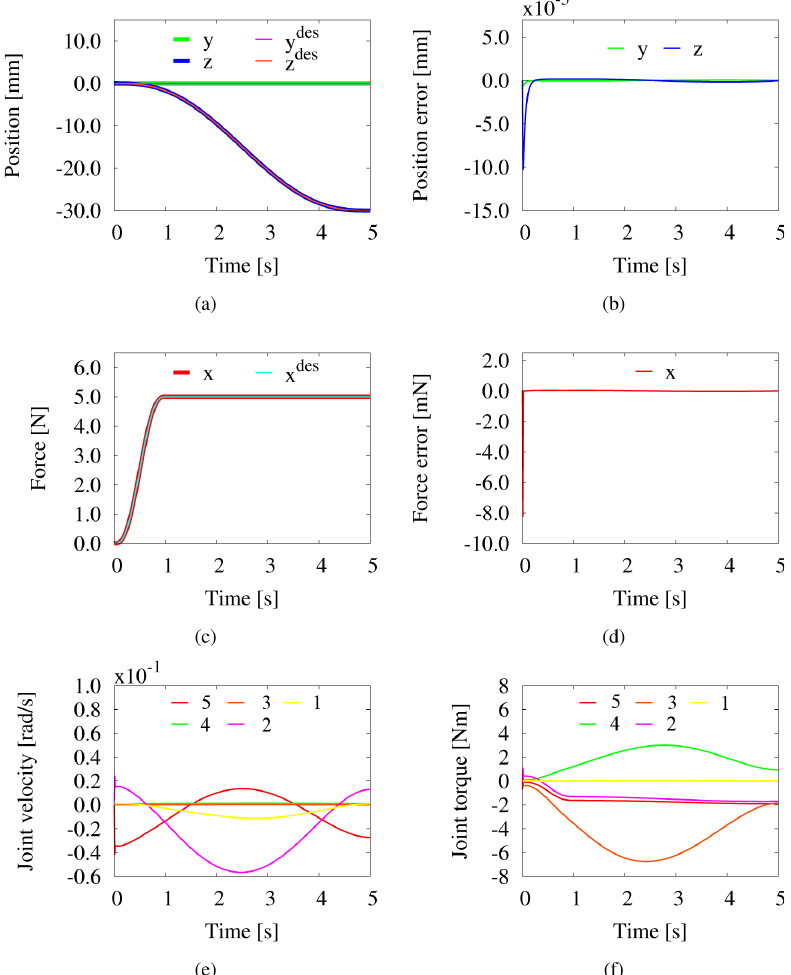
Figure 14. Simulation results under RNS-based dynamical motion / force feedback control: the desired motion trajectory in hand coordinates is a 30mm straight line downwards (along -z); the hand force (x component) is regulated thereby to